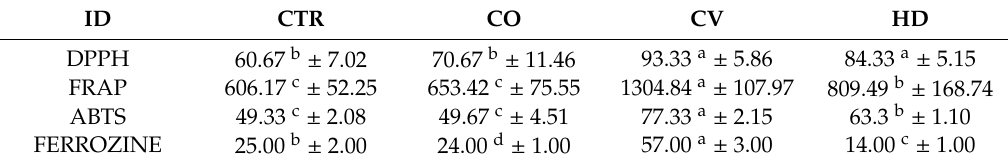
Table 3. Antioxidant activities (2,2-diphenyl-1-picrylhydrazyl radical (DPPH, % inhibition); ferric reducing antioxidant power (FRAP, ( µ M TE g -1 FW); Trolox equivalent antioxidant capacity assay TEAC ABTS %; Ferrozine (% inhibition) in red Topepo fruits grown in unfertilized soil (control, CTR) and soils fertilized with compost from olive wastes (CO), compost from vegetable wastes (CV), and horse dung (HD). ID CTR